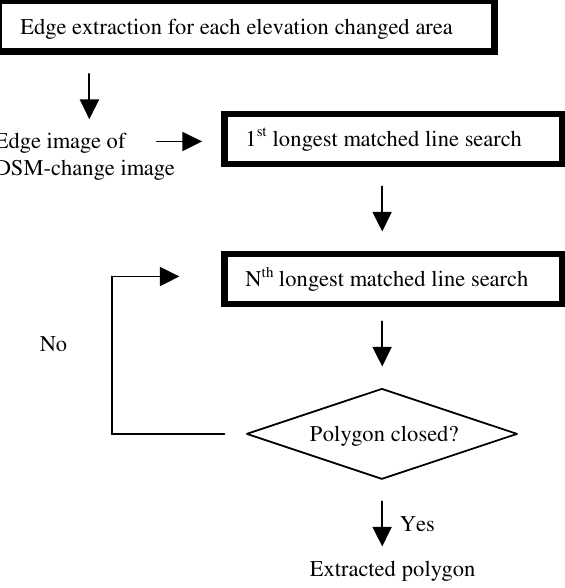
Figure 6: Flowchart of polygon extraction method